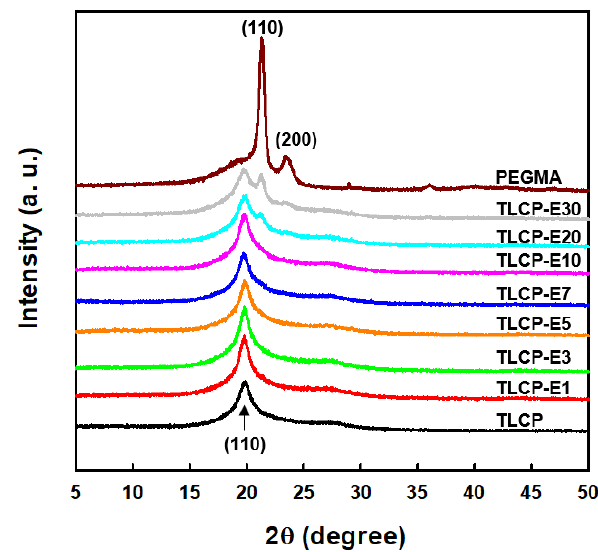
ff raction patterns of neat TLCP, neat PEGMA, and TLCP / PEGMA Figure 5. X-ray diffraction patterns of neat TLCP, neat PEGMA, and TLCP/PEGMA blends. Figure 5. X-ray di